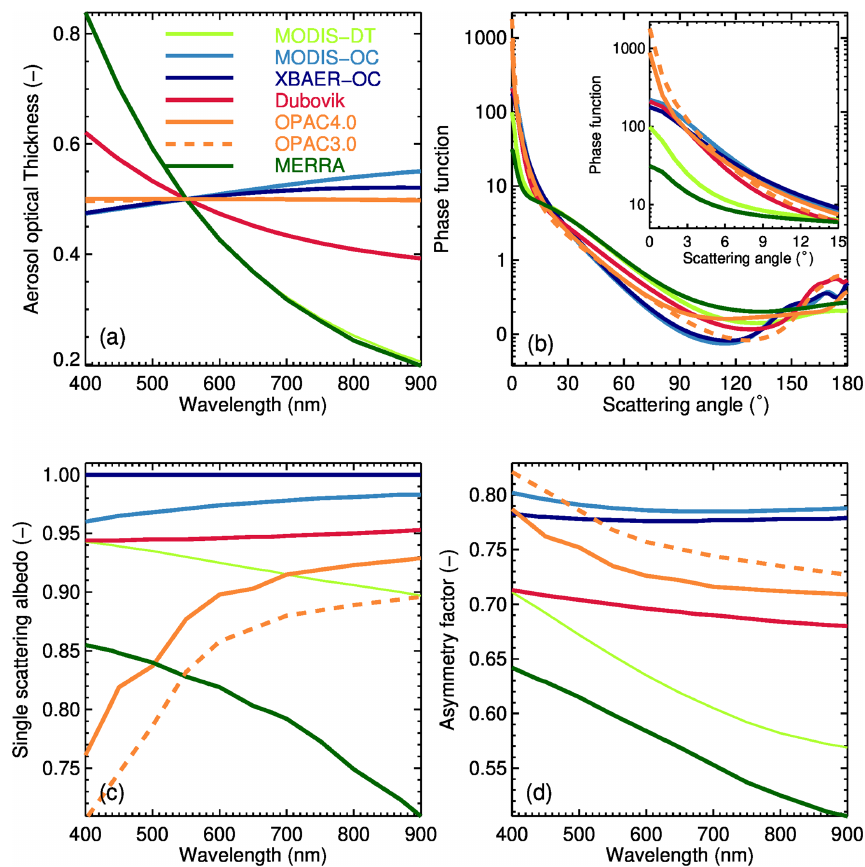
Figure 2. Optical properties of the aerosol types newly implemented in SCIATRAN (indicated by different colors): (a) wavelength-dependent AOT; (b) phase function at a wavelength of 0.55µm (with a zoom-in panel in the upper-right corner); (c) wavelength-dependent single- scattering albedo; (d) wavelength-dependent asymmetry